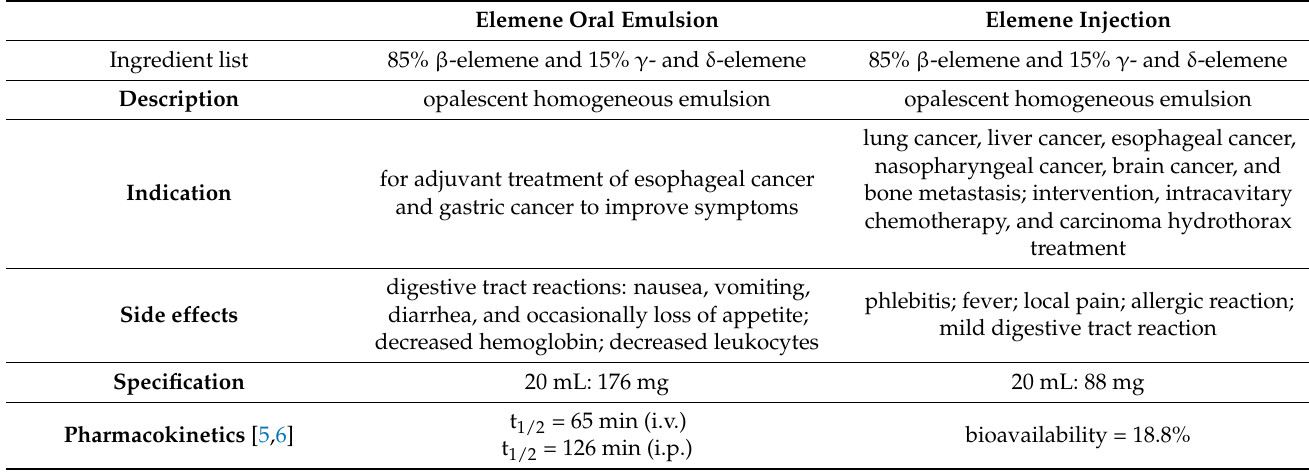
Figure 1. The plant source, commercial products, and the structure of β -elemene. Table 1. The specific information of elemene oral emulsion and elemene